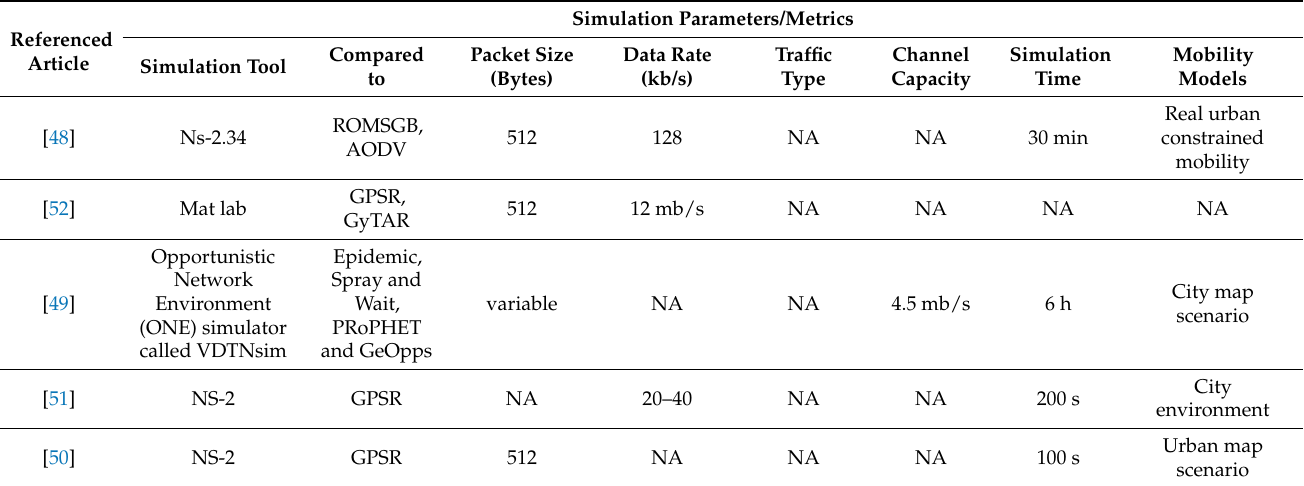
Table 12. Simulation parameters of city map scenario-based routing protocols.